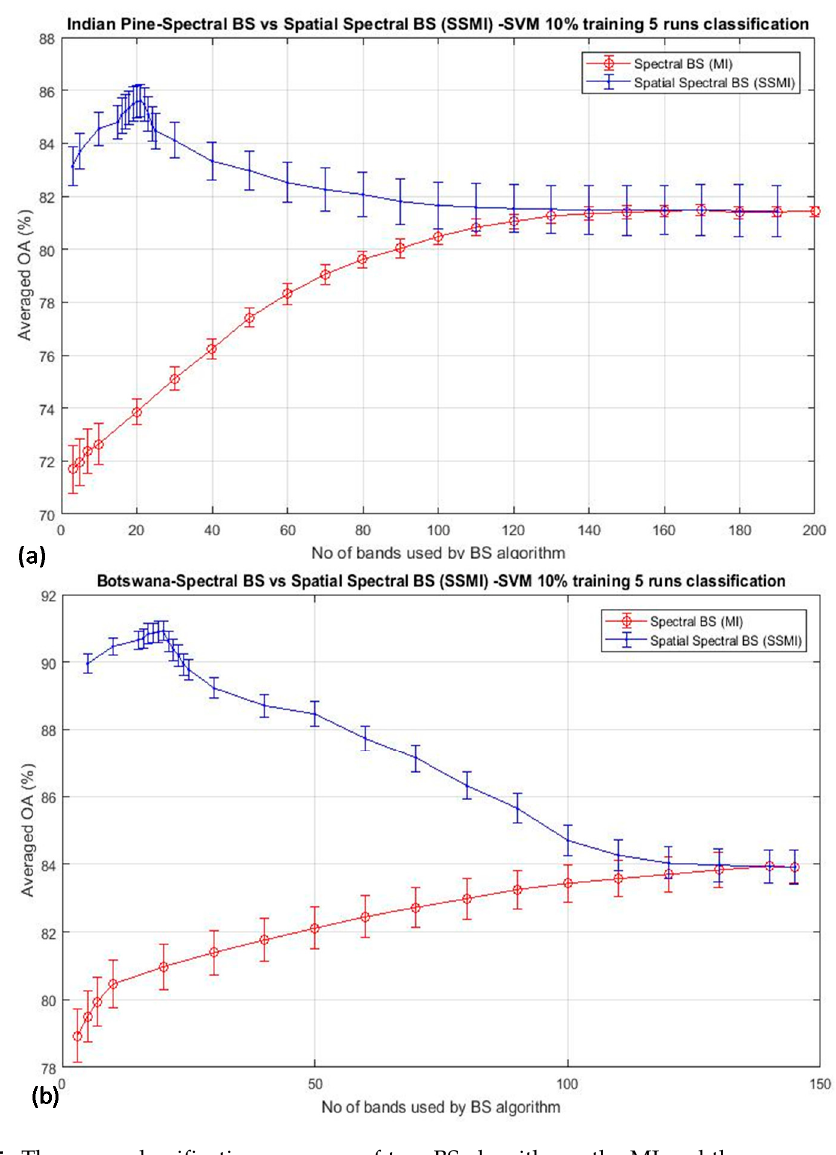
Figure 5. The mean classification accuracy of two BS algorithms: the MI and the proposed spatial spectral mutual information (SSMI), as function of the number of bands used for the classification: ( a ) Indian Pine and ( b ) Botswana datasets. In both cases, a ‘bell’-shaped accuracy-dimensionality curve similar to that predicted by Hugh [1], is seen, for the first time, from the experimental result of the proposed SSMI scheme (in blue plot). This is in great contrast to the basic MI algorithm (in red plot), which increases the accuracy steadily when more bands are utilized for classification.